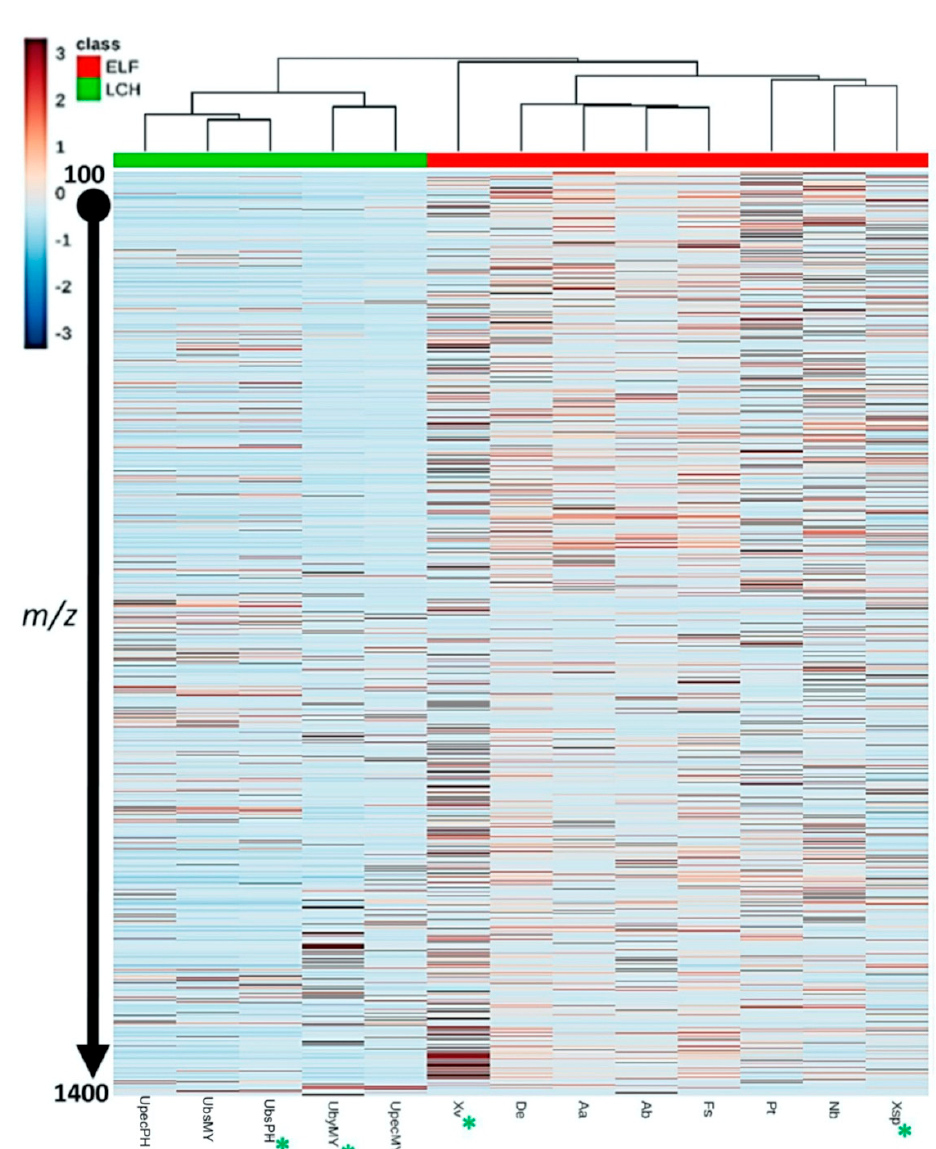
Figure 1. Heatmap and dendrogram of crude lichen and ELF extracts. The presence of more red bars indicates higher diversity in their chemical profile. Those marked with an asterisk (*) were chosen for further fractionation work. (ELF: endolichenic fungi, LCH: lichen)